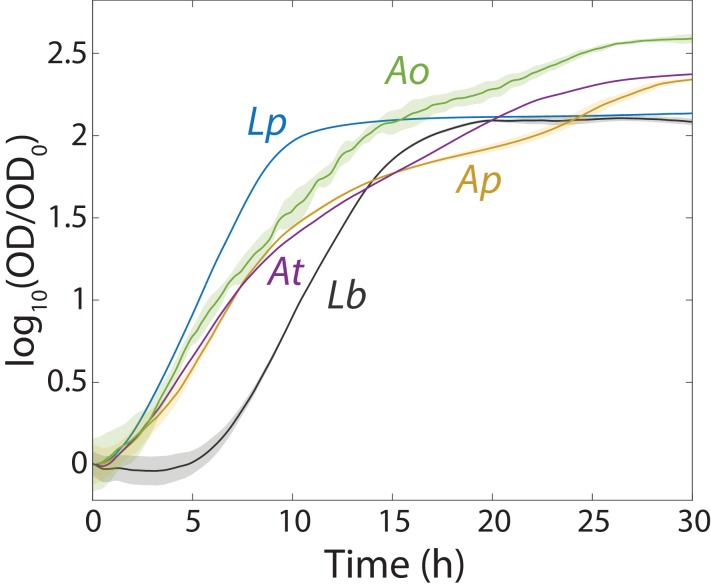
Growth curves of monocultures of the primary species in the fruit fly gut microbiota measured with a plate reader (Materials and methods).Data were normalized by the initial OD (t = 0) for each curve. Lactobacillus plantarum, Lp; L. brevis, Lb; Acetobacter pasteurianus, Ap; and A. tropicalis, At. Shaded regions are standard deviation, n = 16. Data points were taken every 8.3 min.